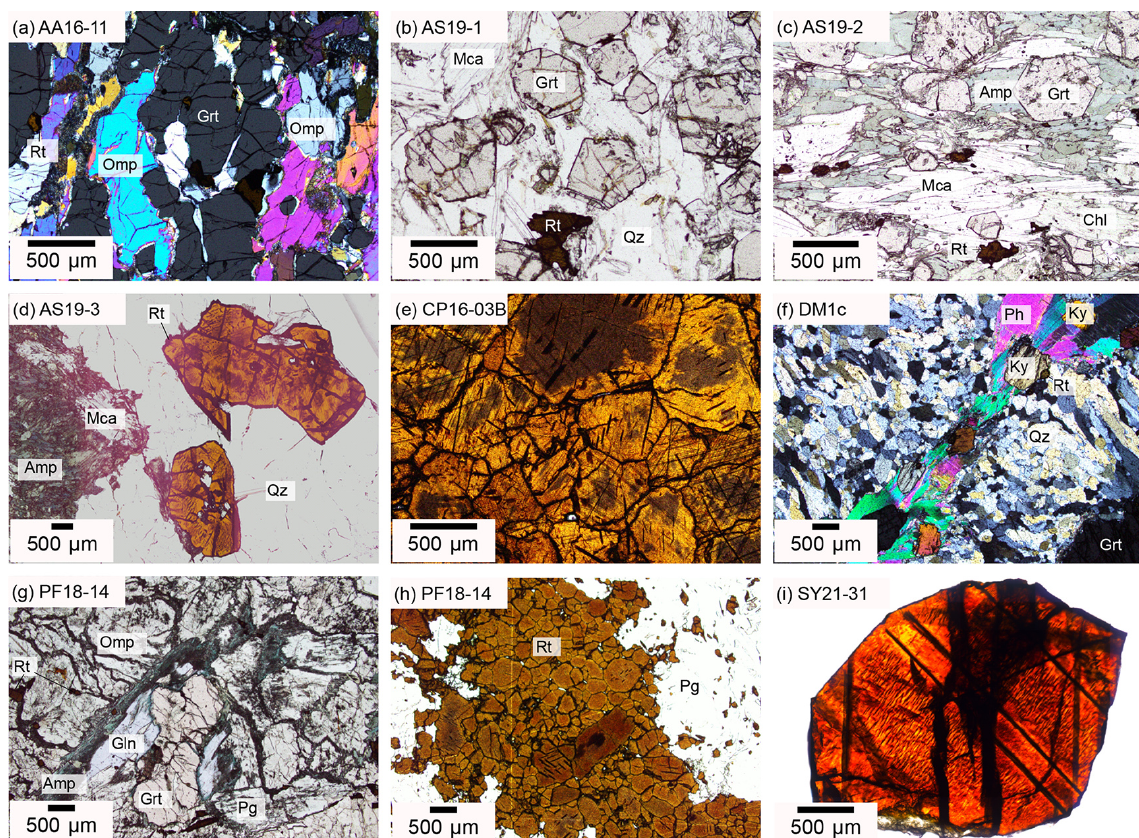
Figure 3. Optical microphotographs of investigated samples depicting textures and mineralogical assemblages. (a, f) XPL, (b–d, g–h) PPL, (i) transmitted light. (a) Sample AA16-11 contains elongated garnet and omphacite grains and shows slight foliation defined by elongated matrix grains. (b) Sample AS19-1 has a matrix of quartz and white mica. Garnet forms large euhedral porphyroblasts. Rutile occurs as large grains or aggregates with ilmenite exsolution lamellae. (c) Sample AS19-2 has a pronounced foliation defined by white mica, chlorite, and amphiboles. Garnet porphyroblasts of varying size form pressure shadows containing finer-grained amphiboles. (d) Sample AS19-3 has a similar mineralogy as AS19-2 but does not show any foliation. A massive quartz vein contains centimetre-sized, elongated rutile with minor ilmenite exsolution lamellae. (e) Sample CP16-03B contains purely rutile. Rutile grains are optically zoned with bright rims and dark, blue tinted cores. (f) Sample DM1c has a matrix of quartz and phengite, with rounded kyanite porphyroblasts and large centimetre-sized, strongly resorbed garnet. (g, h) Sample PF18-14 has a matrix of omphacite and paragonite with garnet and glaucophane porphyroblasts and retrograde amphibole rims around garnet and omphacite. Rutile occurs as large vein-like aggregate of several hundreds of grains. Larger rutile grains are optically zoned with light rims and dark blue-grey cores. (i) Sample SY21-31 is a single rutile grain with ilmenite exsolution lamellae and two groups of approximately parallel fractures. Mineral abbreviations after Warr